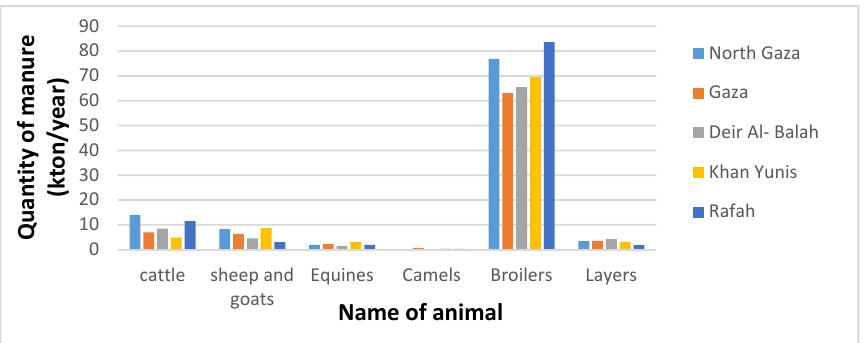
Figure 4. Animal manure produced in each Governorate.